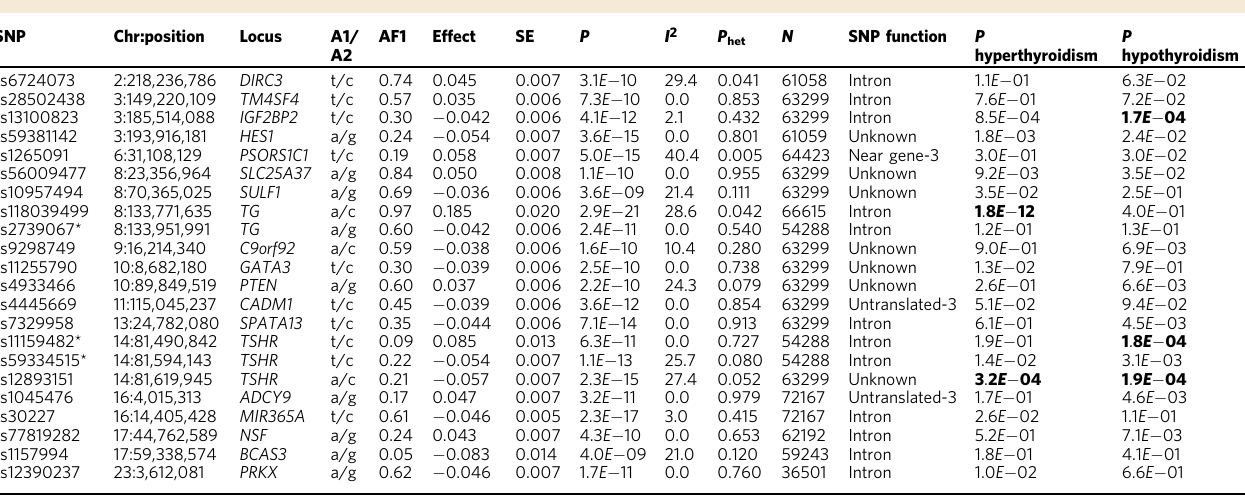
The table contains the list of the index SNPs and additional independent associations of replicated TSH susceptibility loci. The values are provided for the combined discovery and replication sample, for additional independent hits (*) for the discovery stage only